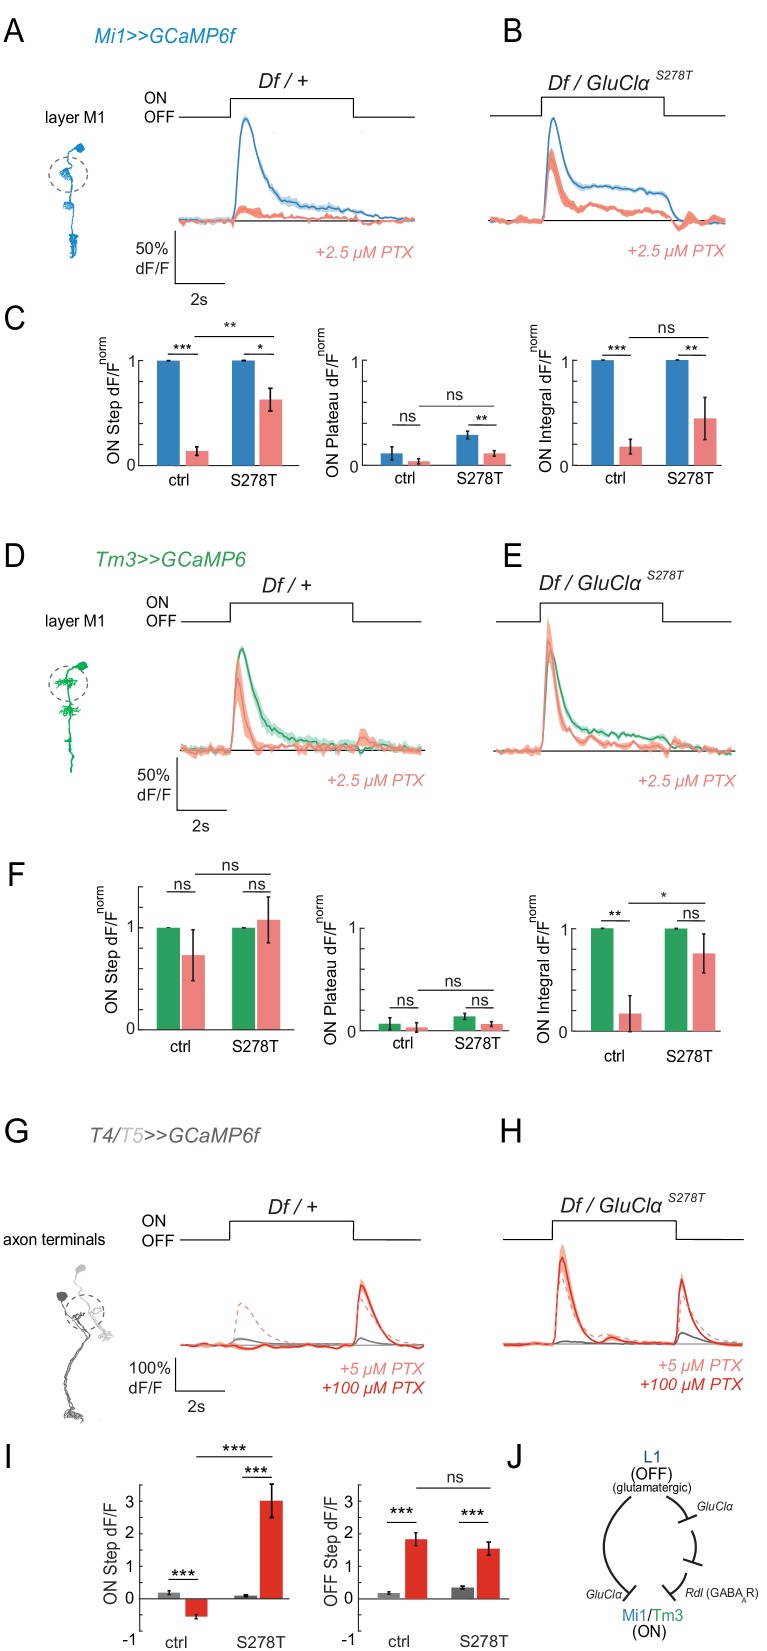
Pharmacogenetics shows that ON responses are mediated by GluClα.(A,B) In vivo calcium signals in response to full-field flashes recorded in layer M1 of Mi1 neurons. Figure shows traces before (blue) and after (red) 2.5 µM PTX application in heterozygous GluClαDf/+ deficient controls (A, n = 5 [63]), as well as flies only expressing the PTX-insensitive GluClαS278T allele (GluClαS278T/GluClαDf).(B, n = 5 [47]). (C) Bar plots showing the quantification of the data from (A,B). *p<0.05, **p<0.01, ***p<0.001, tested with an unbalanced two-way ANOVA, corrected for multiple comparisons. (D,E) In vivo calcium signals in response to full-field flashes recorded in the layer M1 of Tm3 neurons. Figure shows traces before (green) and after (red) PTX application in heterozygous GluClα Df/+ deficient controls (D, n = 5 [30]), as well as flies only expressing the PTX-insensitive GluClαS278T allele (GluClαS278T/GluClαDf) (E, n = 5 [40]). (F) Bar plots showing the quantification of the data shown in (D,E). *p<0.05, **p<0.01, ***p<0.001, tested with an unbalanced two-way ANOVA, corrected for multiple comparisons. (G,H) In vivo calcium signals in response to full-field flashes recorded in T4/T5 axon terminals. Figure shows traces before (gray) and after (red) 100 µM PTX application in heterozygous GluClα Df/+ deficient controls (G, n = 10[440]), as well as flies only expressing the PTX-insensitive GluClαS278T allele (GluClαS278T/GluClαDf) (H, n = 5[192]). The pink dotted line shows responses after the application of 5 µM PTX. (I) Bar plots showing the quantification of the data shown in (G,H). *p<0.05, **p<0.01, ***p<0.001. Statistics was done using an unbalanced two-way ANOVA, corrected for multiple comparisons. All traces show mean ± SEM. Sample sizes are given as number of flies (number of cells). (J) Schematic summarizing the results. Our results provide support for a combinatorial role of glutamatergic and GABAergic inhibition in mediating ON responses. Since GluClα is likely to be the receptor on all neurons postsynaptic to L1, Rdl could function downstream of GluClα.10.7554/eLife.49373.024Figure 6—source data 1.Table 1 contains all mean ± s.e.m.Data related to quantifications shown in main Figure 6, sorted by genotype and experimental condition.